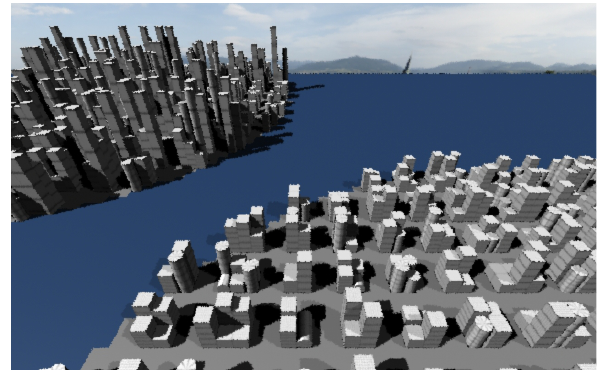
After 7 additional generations, the final candidate was found. Figure 10 shows the originally requested water, a distinct centre with high buildings on the left and low-rise buildings on the right side of frame. While the result satisfied all criteria of the brief, it required 47 generations to achieve it.